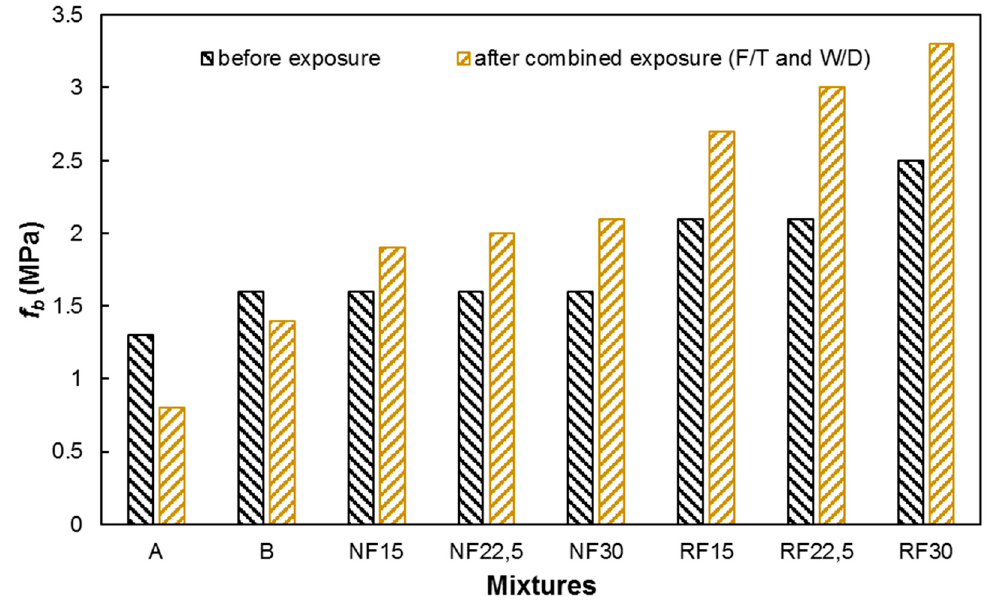
Figure 21. Pull-o ff adhesion f b of the repair assembly from pull-o ff test (based on the results presented Figure 21. Pull-off adhesion f b of the repair assembly from pull-off test (based on the results presented in in Reference Reference [131]).